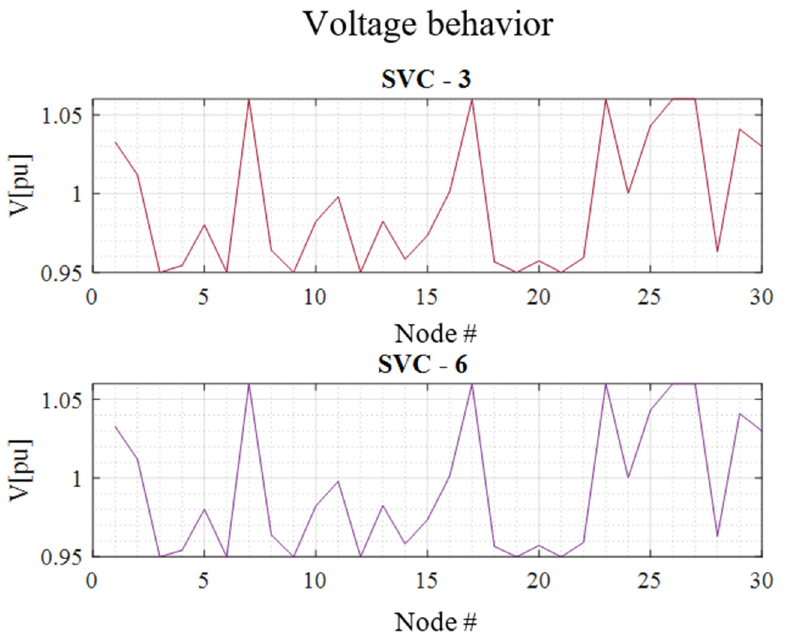
Figure 15. Voltage profile in the IEEE 30-bus test system: SVC 3 and 6.